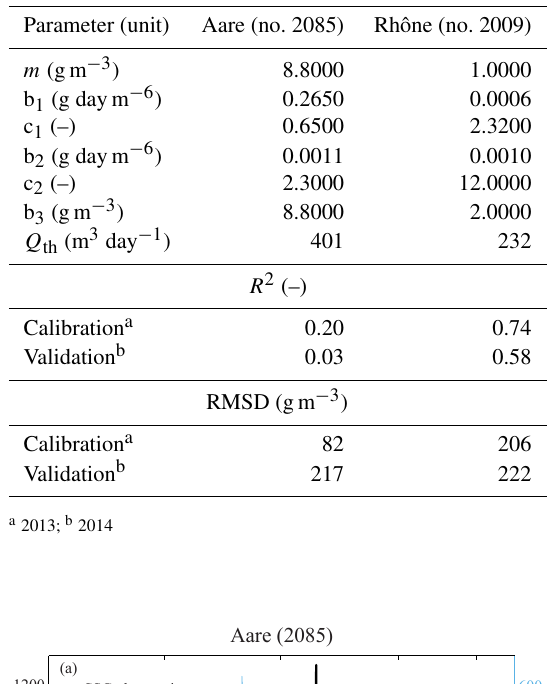
Table 2. River suspended sediment concentration (SSC) model best-fit parameters and model performance statistics reported as coefficients of determination ( R 2 ) and root mean square deviation (RMSD).